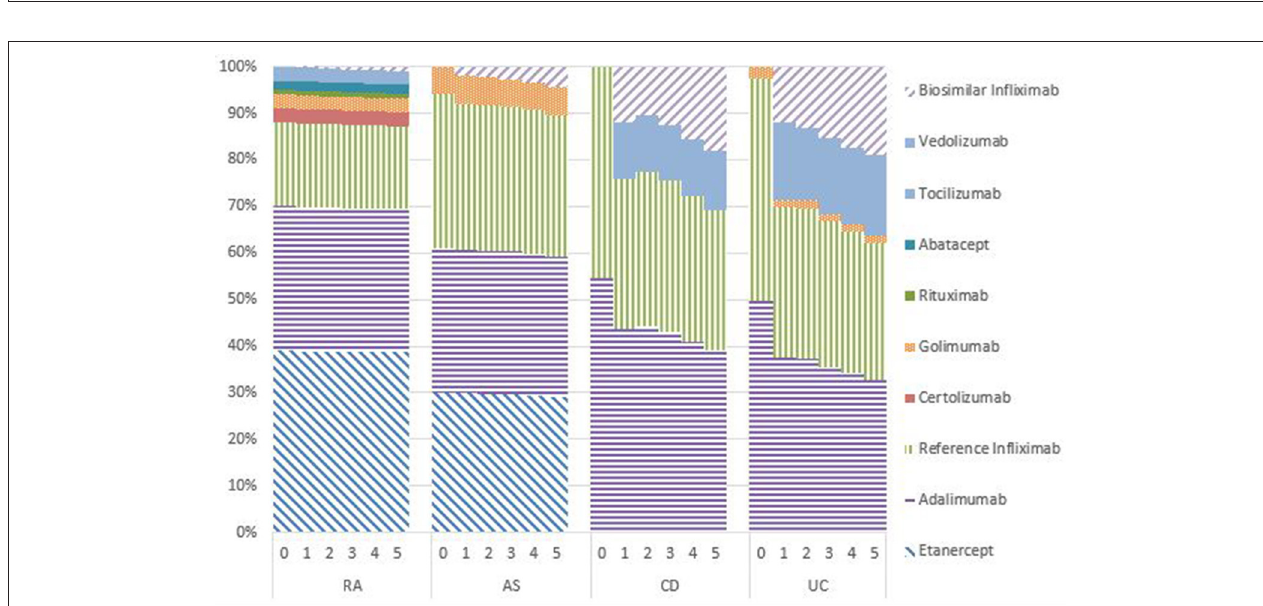
FIGURE 2 | Market shares biologics Germany in years